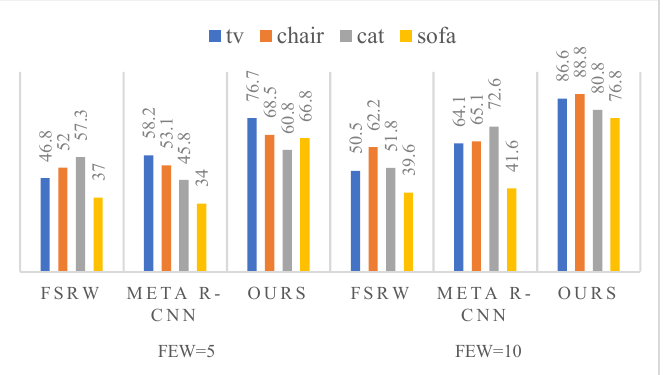
Figure 4. The first experiment on relation reasoning. The classes (sofa and TV, cat and sofa, cat and chair) have strong correlation. The performances of correlated classes are increased.